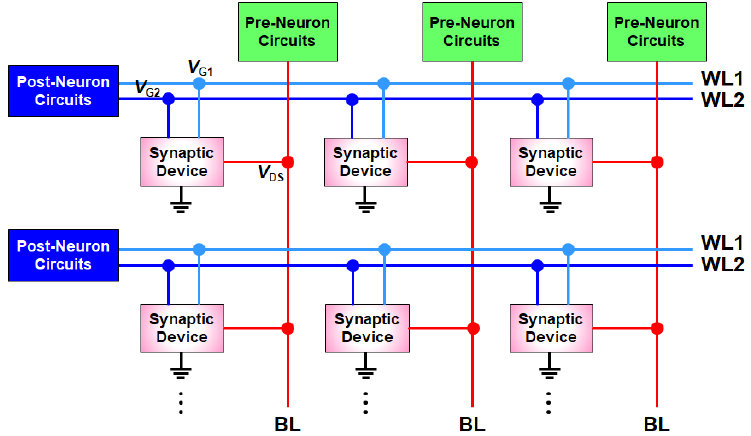
Figure 8. Array architecture with the proposed four-terminal synaptic transistor towards a high- density and high-reliability hardware-driven neuromorphic system.